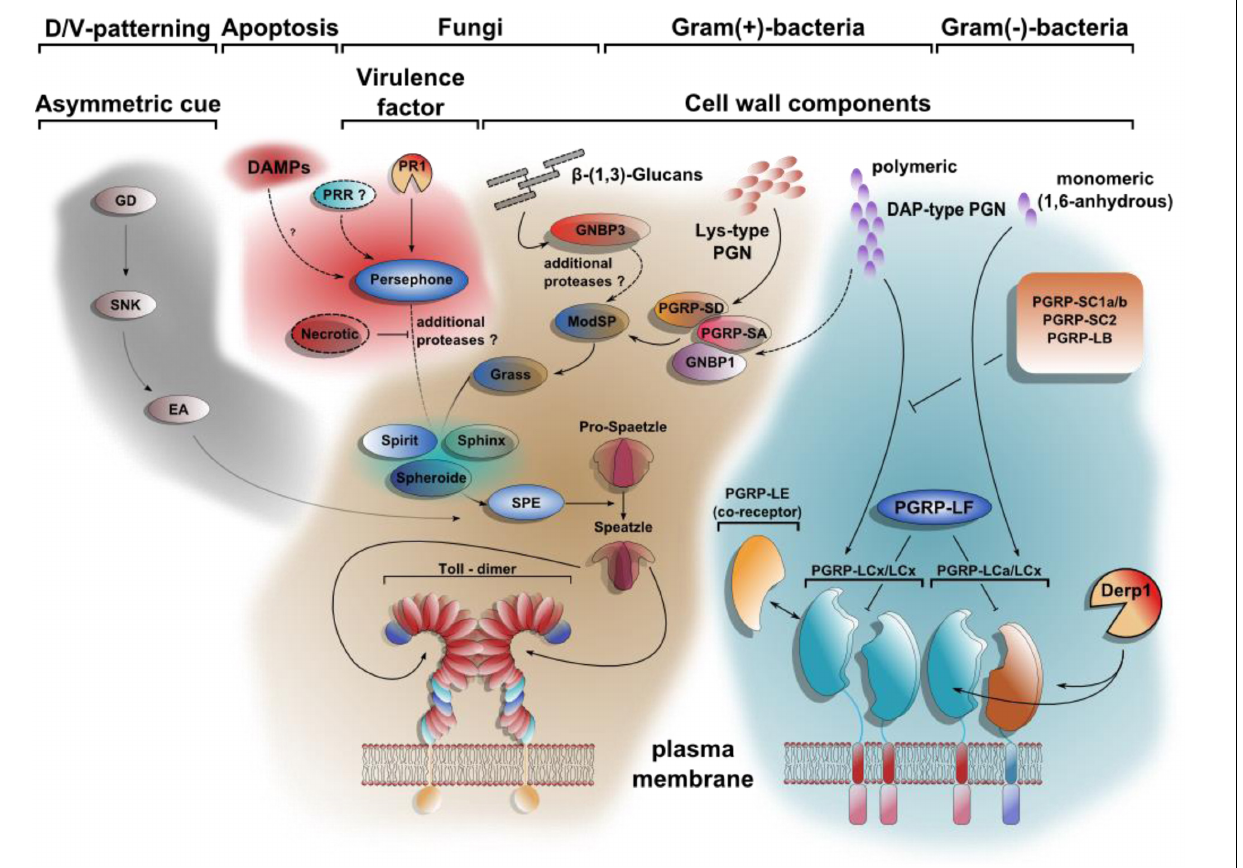
FIGURE 2 | Toll signaling integrates DAMPs and PAMPs. At least four different extracellular pathways activate Spätzle proteolytically. The first comprises a cascade of serine proteases, which defines dorso-ventral polarity in the developing egg. Gastrulation defective (GD), Snake (SNK), and Easter (Ea) induce the hydrolytic cleavage of Spätzle on the ventral side of the embryo. DAMPs can be sensed by Persephone (Psh) as shown for a model with defects in apoptosis. The proteolytic cleavage of Psh by the fungal protease PR1 renders it active as well. The pattern recognition receptor GNBP3 (Gram negative bacteria binding protein 3) senses β -1,3 glucan-stretches from fungal cell walls parallel to PAMPs. The Toll pathway is also required for resistance toward Gram-positive bacteria due to the recognition of polymeric Lys-type PGN by PGRP-SA,